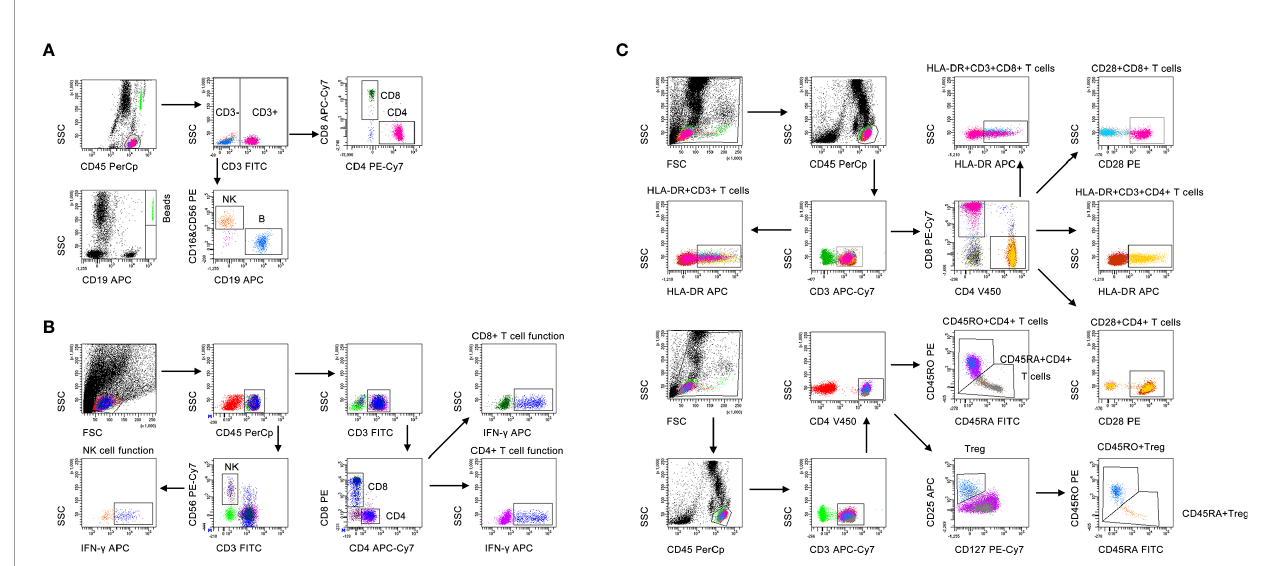
FIGURE 1 | The gating strategies for (A) lymphocyte subset analysis, (B) lymphocyte function, and (C) lymphocyte phenotype